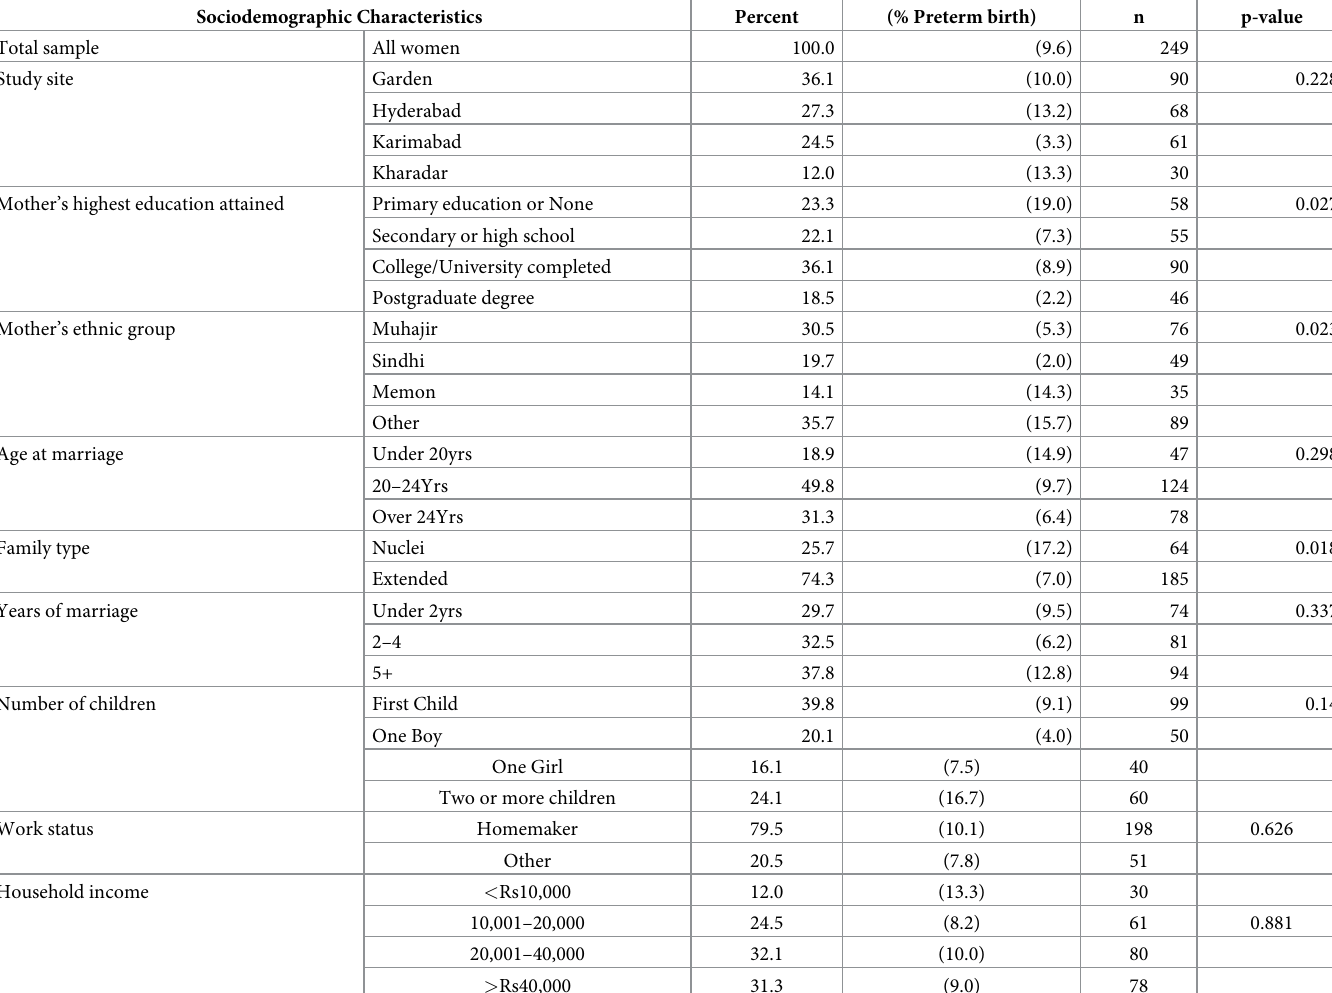
Table 1. Preterm birth rate by sociodemographic